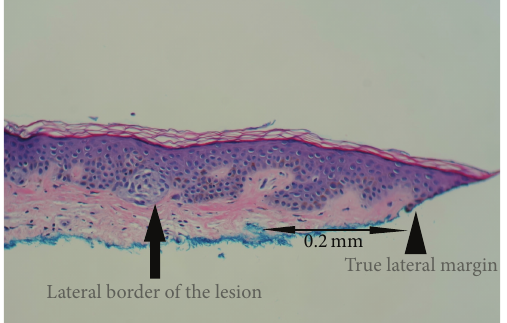
Figure 1: Clear Margin. True lateral border of the lesion: the last junctional melanocytic nest or the last atypical melanocyte (arrow). True lateral margin: the edge of the specimen where dermoepider- mal junction is present (arrowhead) (H&E; 20x).